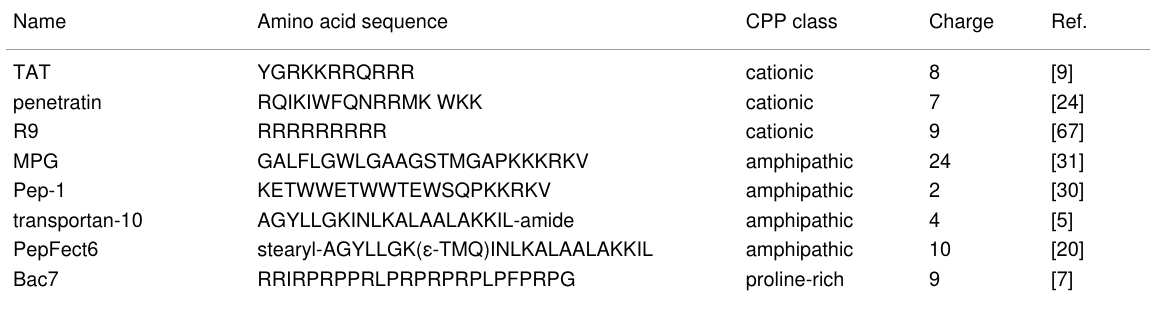
Table 1: Overview of some the most commonly used CPPs describing their sequence, class and